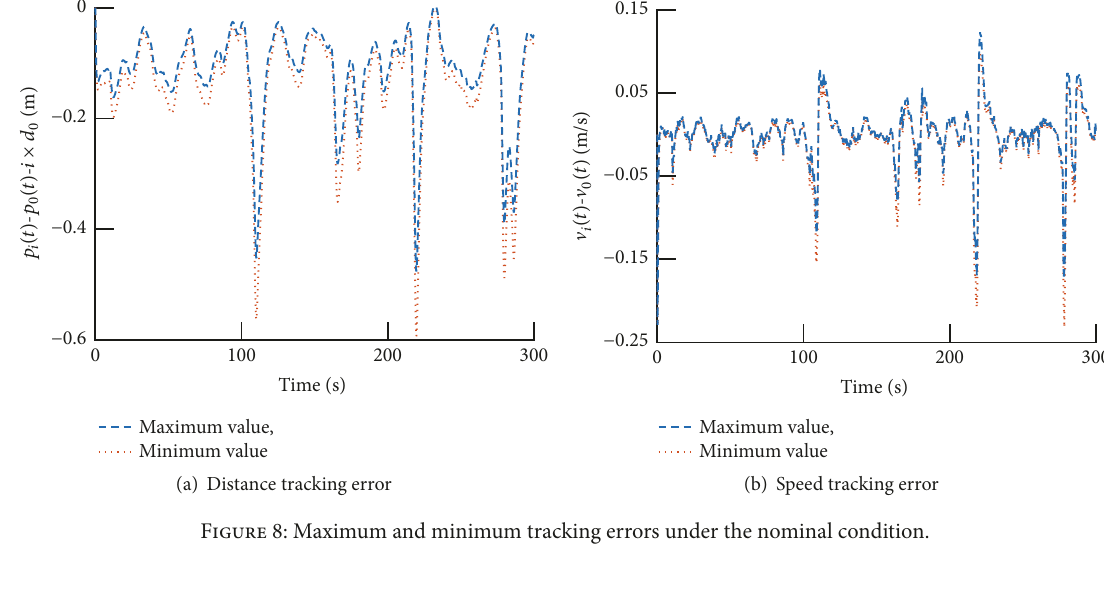
Figure 8: Maximum and minimum tracking errors under the nominal condition.